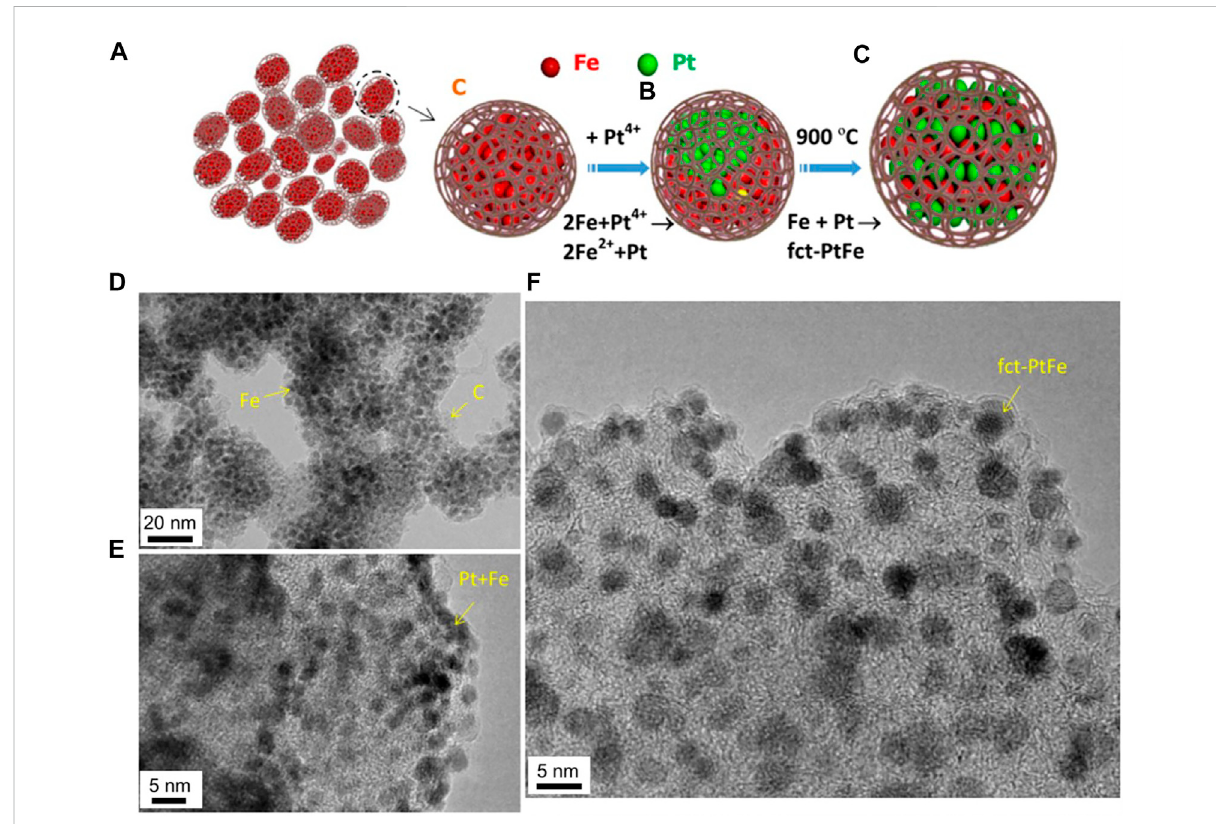
FIGURE 1 Chemical andstructuralevolutions. (A) FineFeparticlesembeddedincarbonmatrix. (B) DepositionofPtparticlesonFefromthereductionofa Pt precursor. (C) Ordered PtFe from structural transformation by heat treatment. (D) TEM image of Fe particles embedded in carbon matrix. (E) Fine Pt/Fe particles in as-deposited state. (F) Fine PtFe particles entrapped in carbon after heat treatment. (Du et al., 2016) Copyright 2016 Energy and Environmental